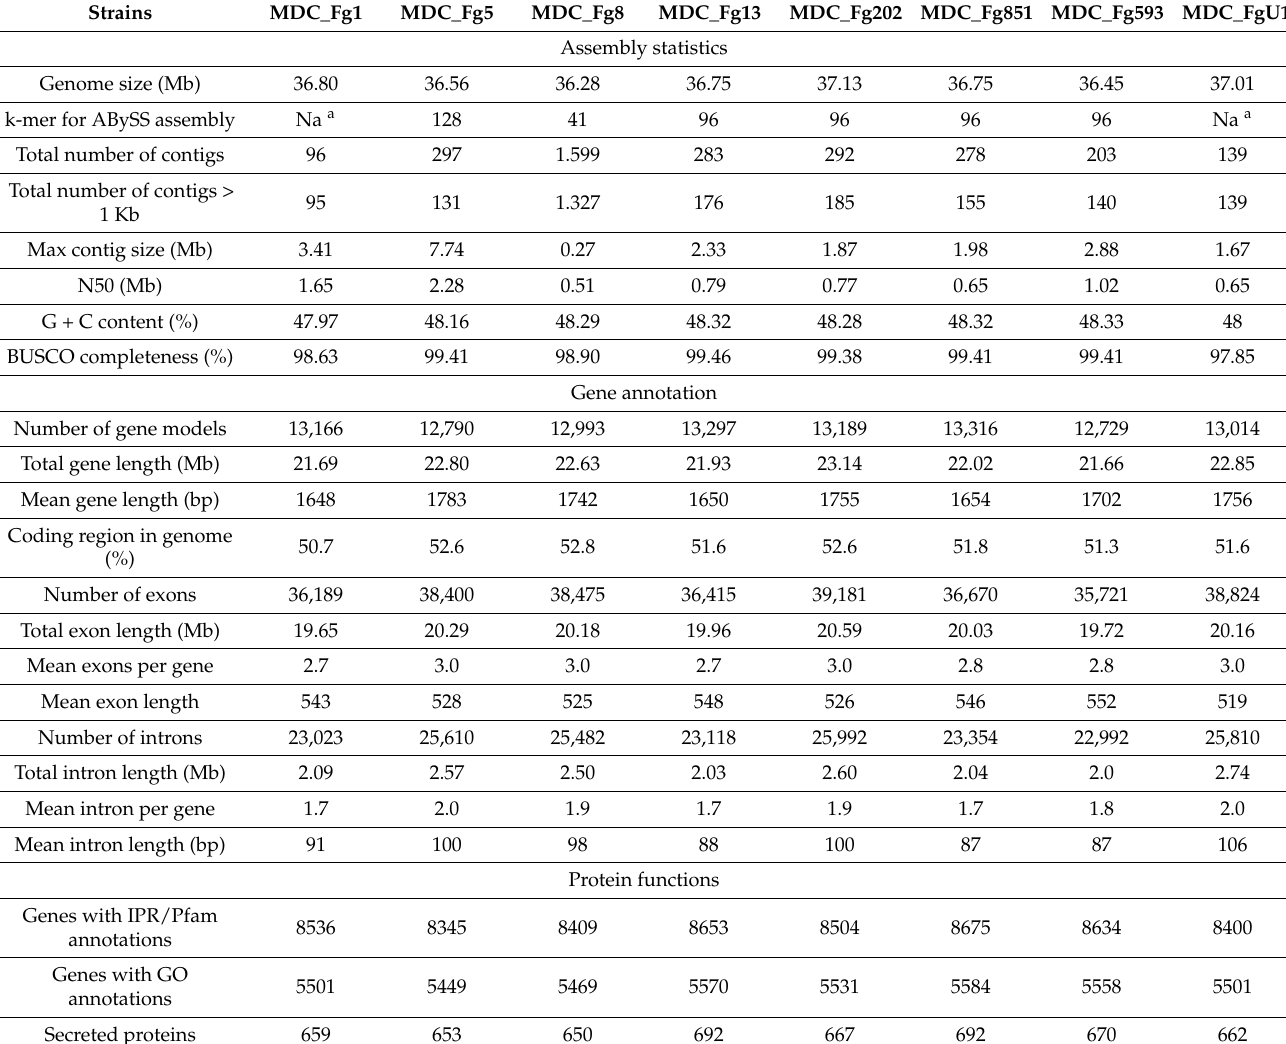
Table 1. Genome assembly and annotation statistics of the eight F. graminearum genomes of this